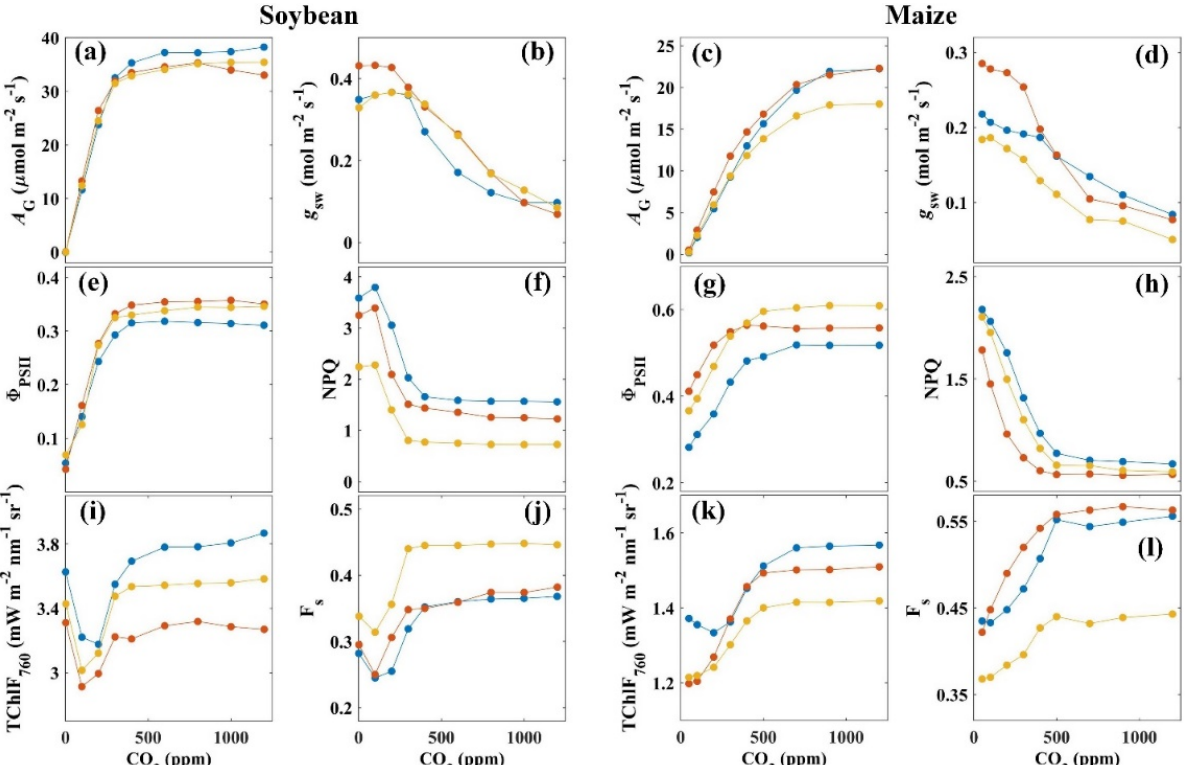
Figure 3. Variation in gross carbon assimilation ( A G , μ mol m − 2 s − 1 , a , c ), stomatal conductance to water vapor ( g sw , mol m − 2 s − 1 , ( b , d )), quantum efficiency of photosystem II ( Φ PSII , ( e , g )), nonphotochemical quenching (NPQ, ( f , h )), total fluorescence radiance at 760 nm measured from both sides of leaves (TChlF 760 , mW m − 2 nm − 1 sr − 1 , ( i , k )), and light-adapted steady-state PAM fluorescence (F s , ( j , l )) with CO 2 concentrations (ppm) measured on three leaves of soybean (left two columns) and maize (right two columns) under irradiance of 800 (soybean) and 1200 (maize) µ mol m − 2 s − 1 . The three different colored lines represent three individual samples. n CO2 = 9 for each leaf. Table 2. Coefficients of determination ( R 2 ) for the linear regressions between fluorescence radiance and photosynthetic capacity for the measurements driven by CO 2 concentration (ppm), leaf tempera- ture ( ◦ C), and abscisic acid (ABA) treatments under constant irradiance of 800 µ mol m − 2 s − 1 . A G represents gross carbon assimilation ( µ mol m − 2 s − 1 ). TChlF 760 and F s represent the total emitted fluo- cence. Bold values indicate regression insignificance ( p ≥ 0.05). This table analyzes four groups of datasets: three individual samples (leaf numbers 1–3) and their average (Set). n CO2 = 8 for individual leaves and 24 for a set. n T = 5 for individual leaves and 15 for a set. n ABA = 30 for individual leaves and 90 for a set. A G Species Treatments Fluorescence Leaf 1 Leaf 2 Leaf 3 Set TChlF 760 0.93 0.94 0.95 0.96 CO 2 F s 0.93 0.94 0.91 0.94 Leaf TChlF 760 0.86 0.91 0.95 0.96 Soybean temperature F s 0.81 0.92 0.75 0.89 0.99 0.95 ABA